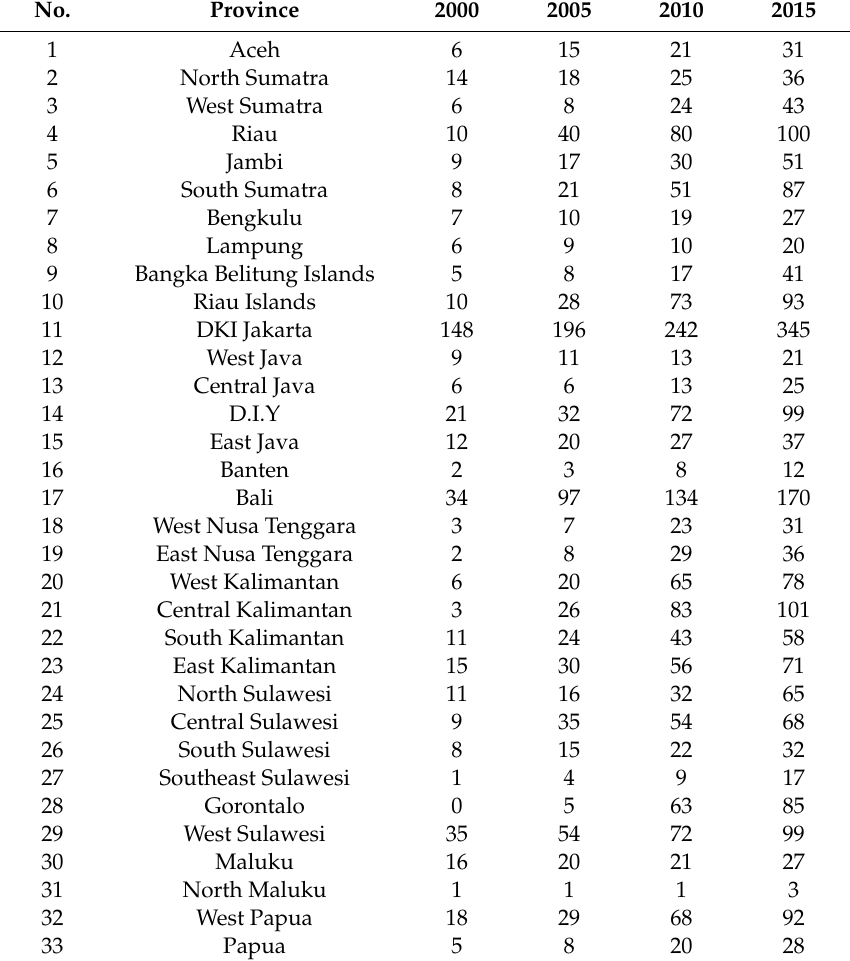
Table 5. Car ownership in provinces, 2000–2015 (Vehicles / 1000